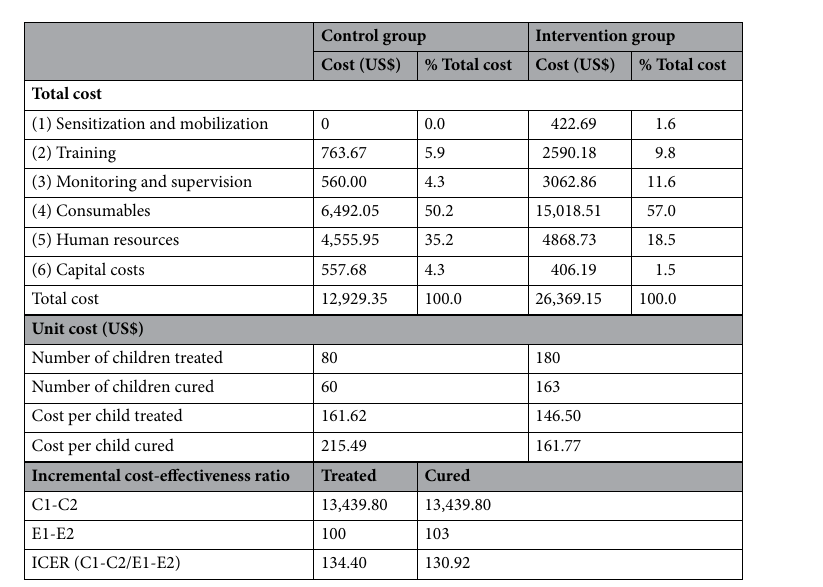
Table 5. Cost analysis. C cost, E effect, ICER Incremental Cost Effectiveness